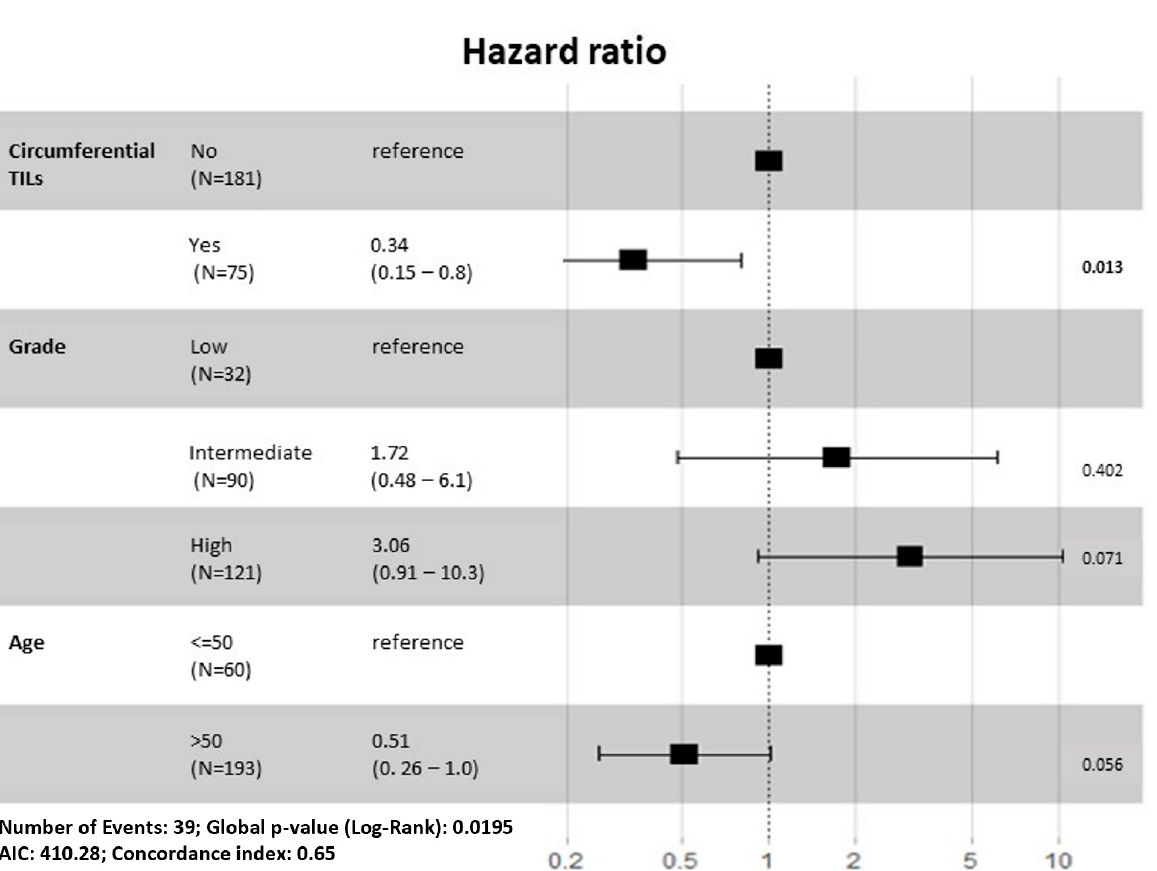
Figure 2. Correlation analysis of tumor-infiltrating lymphocytes (TILs) assessment with clinical outcome; ( A ) Kaplan-Meier (KM) plots for 5-year recurrence-free survival according TILs assessments and clinical parameters (univariable analysis). The significant associations were shown in the figure; ( B ) A forest plot showing the hazard ratio and 95% confidence intervals associated with variables and the primary endpoint (5 year recurrence); Circles represent the hazard ratio and the horizontal bars extend from; abbreviations- Grade-Int, Grade intermediate; HR-Hormone receptor status.